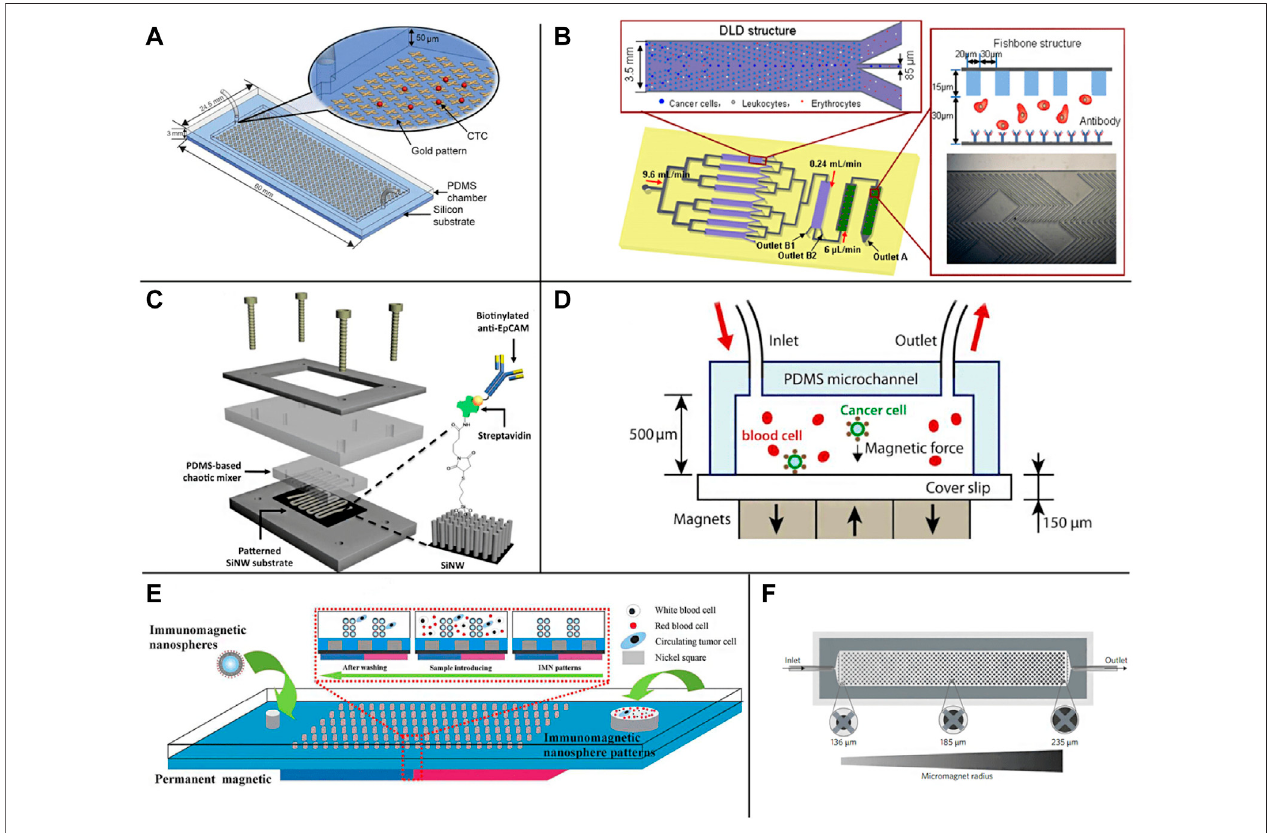
FIGURE 1 | Schematic illustration of the EpCAM speci fi c recognition chips. (A) The GO chip (Yoon et al., 2013); (B) The deterministic lateral displacement (DLD) chip(Liu etal.,2013); (C) TheNanoVelcro CTCchip (Luetal.,2013); (D) Themicrochip designed forimmunomagneticdetection ofcancercell(Hoshinoetal.,2011); (E) The magnetic nanospheres (MNs) based micro fl uidic device (Tang et al., 2016); (F) The wavy-HB micro fl uidic device (Shi et al.,